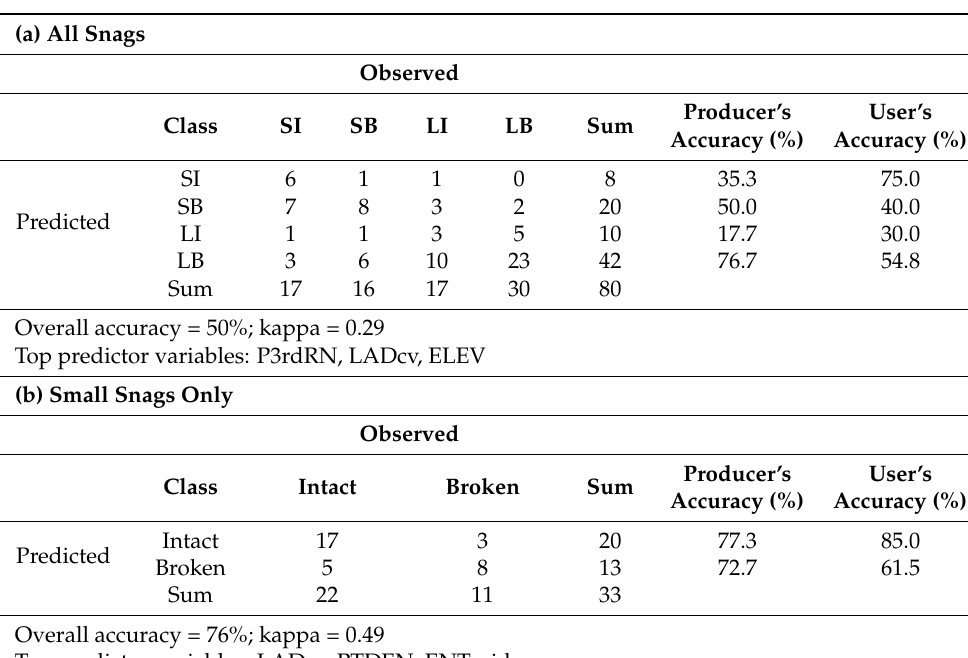
Table 4. Confusion matrices from the top random forest models for classifying snags within conifer forests in Idaho, USA. RF classification used ALS lidar metrics to split snags into groups across known characteristics. There were three RF models used across the full dataset: ( a ) all snags (split into four classes: “small intact” (SI), “small broken” (SB), “large intact” (LI), and “large broken” (LB); n train = 118, n test = 80); ( b ) small-diameter snags only (using intactness as a binary class; n train = 49, n test = 33); and ( c ) large-diameter snags only (using intactness as a binary class; n train = 69, n test = 47). In each table, the matrix on the left shows the number of correct and incorrect classifications per snag class; correct classifications are those where the predicted matched the observed snag class, highlighted in grey on the diagonal. On the right, the accuracy metrics per class are shown in grey: producer’s accuracy (correct/observed sum) and user’s accuracy (correct/predicted sum). Overall accuracy and the kappa statistic are listed in the bottom-left corner of each table, below which are the top three predictor variables for the model (ranked by mean decrease in Gini).